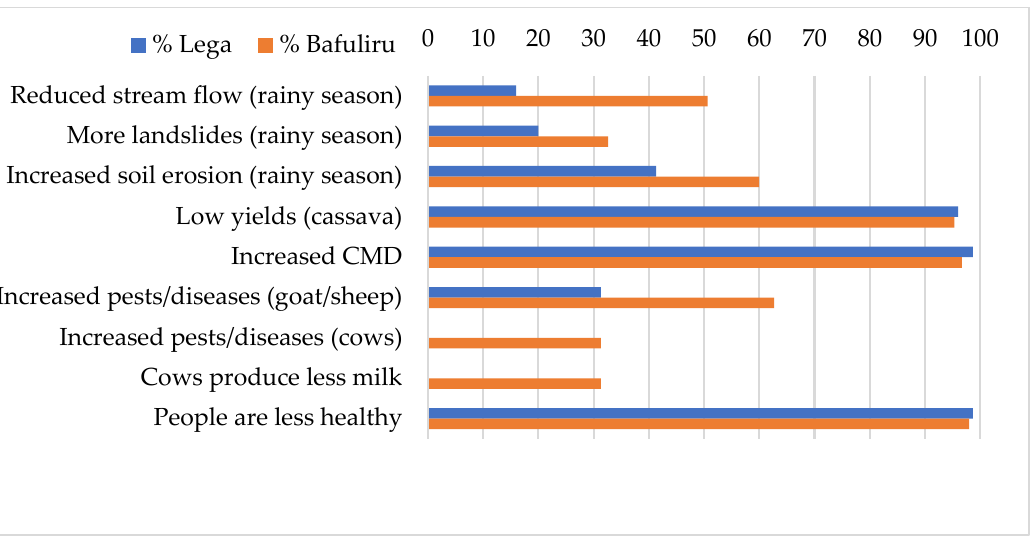
Figure 2. Perceived climatic changes per ethnic group ( n = 150 Bafuliru, n = 150 Lega).